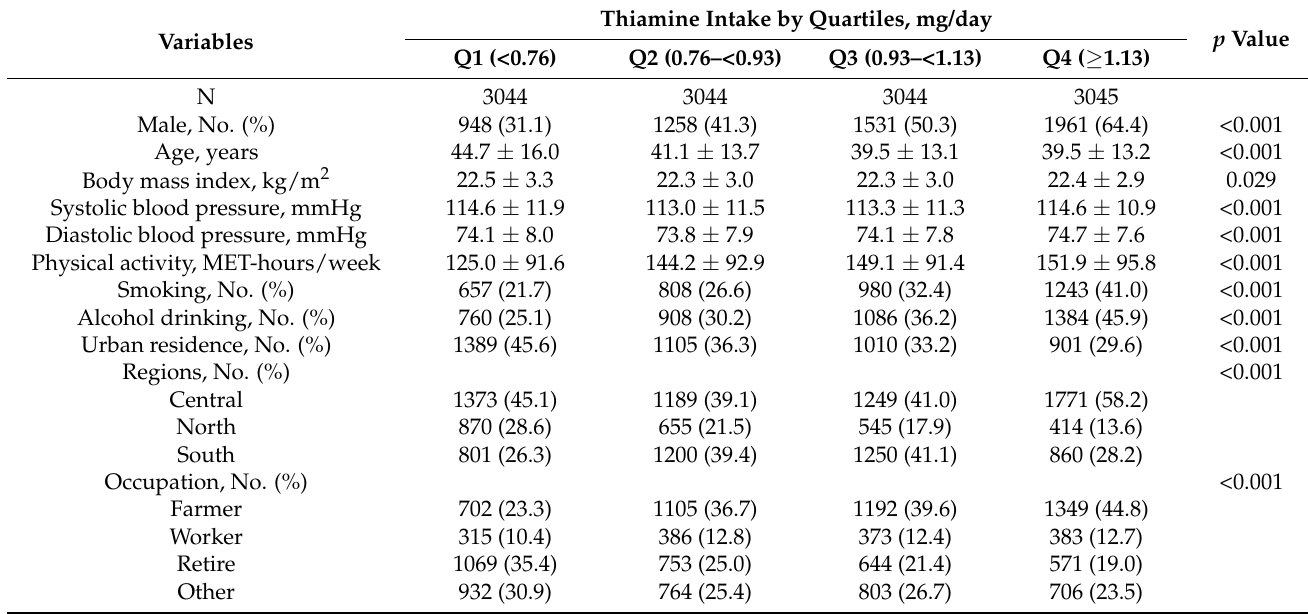
Table 1. Characteristics of the participants by quartiles of dietary thiamine intake *